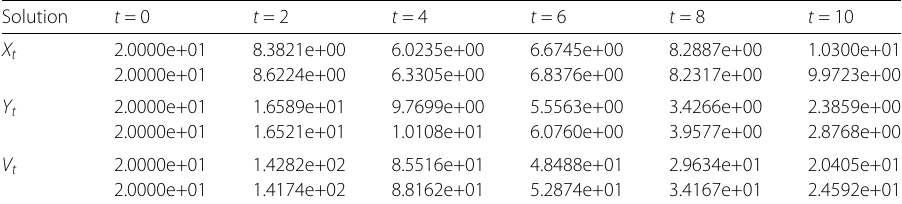
Table 4 Approximate solutions using RK4 (first row) and numerical technique (59) (second row, Ω = 0.98) with step-size h = 10 –3 over [0,10] for X (0) = Y (0) = V (0) = 20 having parameter p =